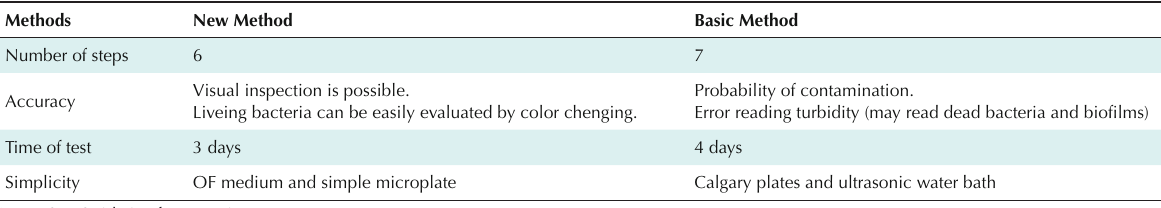
Table 3. Comparison of the New Method With the Previous and Basic Methods